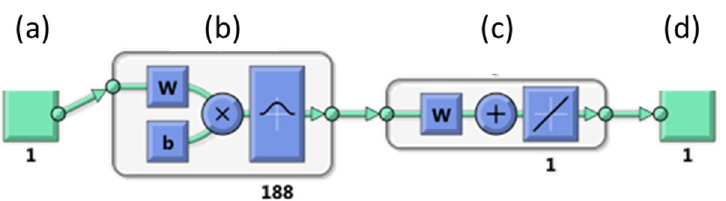
Figure 8. The GRNN training diagram built using MATLAB built-in newgrnn function; ( a ) 1 neuron input layer; ( b ) 188 neurons radial basis layer; ( c ) 1 neuron summation layer; and ( d ) 1 neuron output layer.